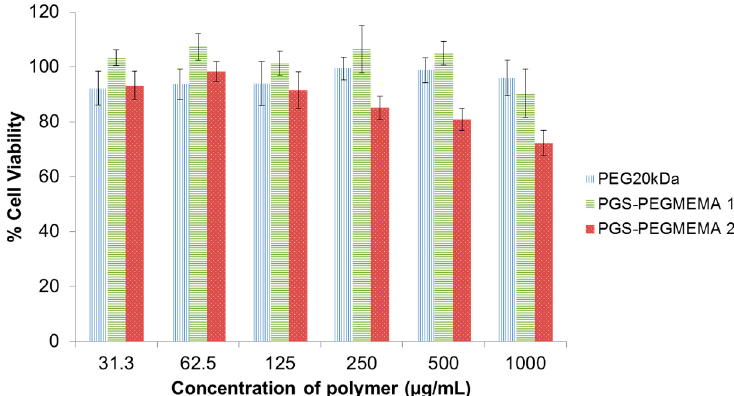
Figure 3. Biocompatibility of PGS-PEGMEMA 1 and 2 as compared to the control of PEG20kDa. Both PGS-PEGMEMA polymers showed very good biocompatibility with the human fibroblast cells.